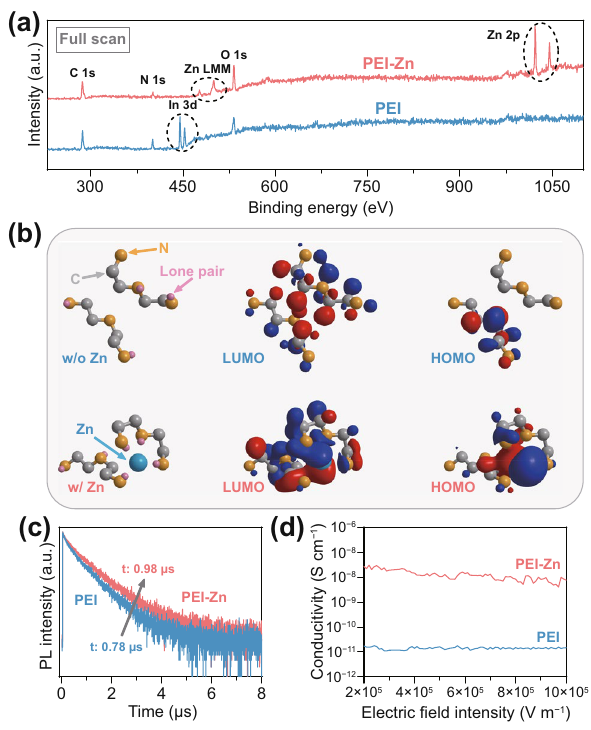
Fig. 2 a XPS spectra of a PEI and a PEI‑Zn layers coated on ITO substrates. b Optimized structure and molecular orbitals of two enam‑ ine molecules with and without zinc ions. c Transient PL charac‑ teristics (@520 nm) of green emitting layer (CBP:10 wt% Ir(ppy) 3 ) deposited, respectively, on PEI and PEI‑Zn. d Conductivity of PEI and